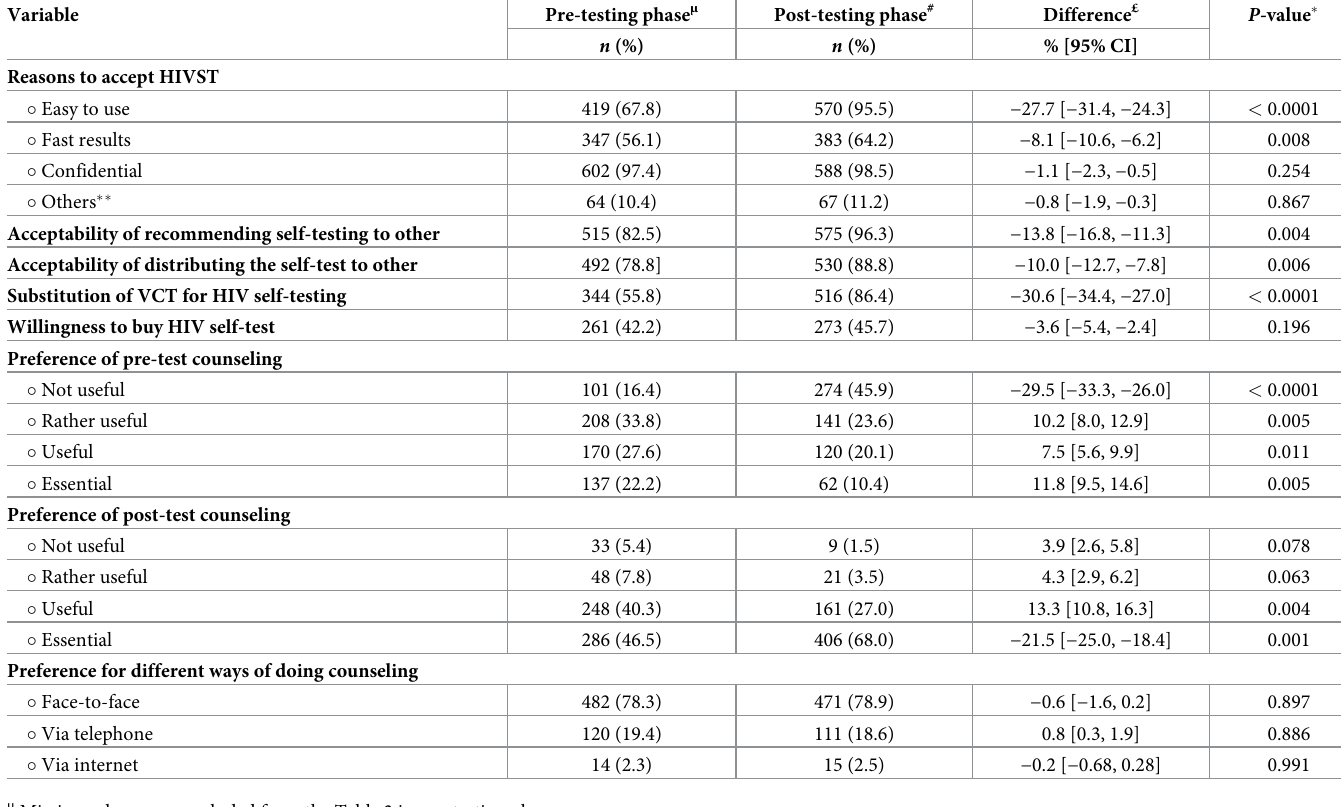
Table 2. Acceptability of and preferences for HIV self-testing according to pre-testing and post-testing phases among 597 adolescents living in